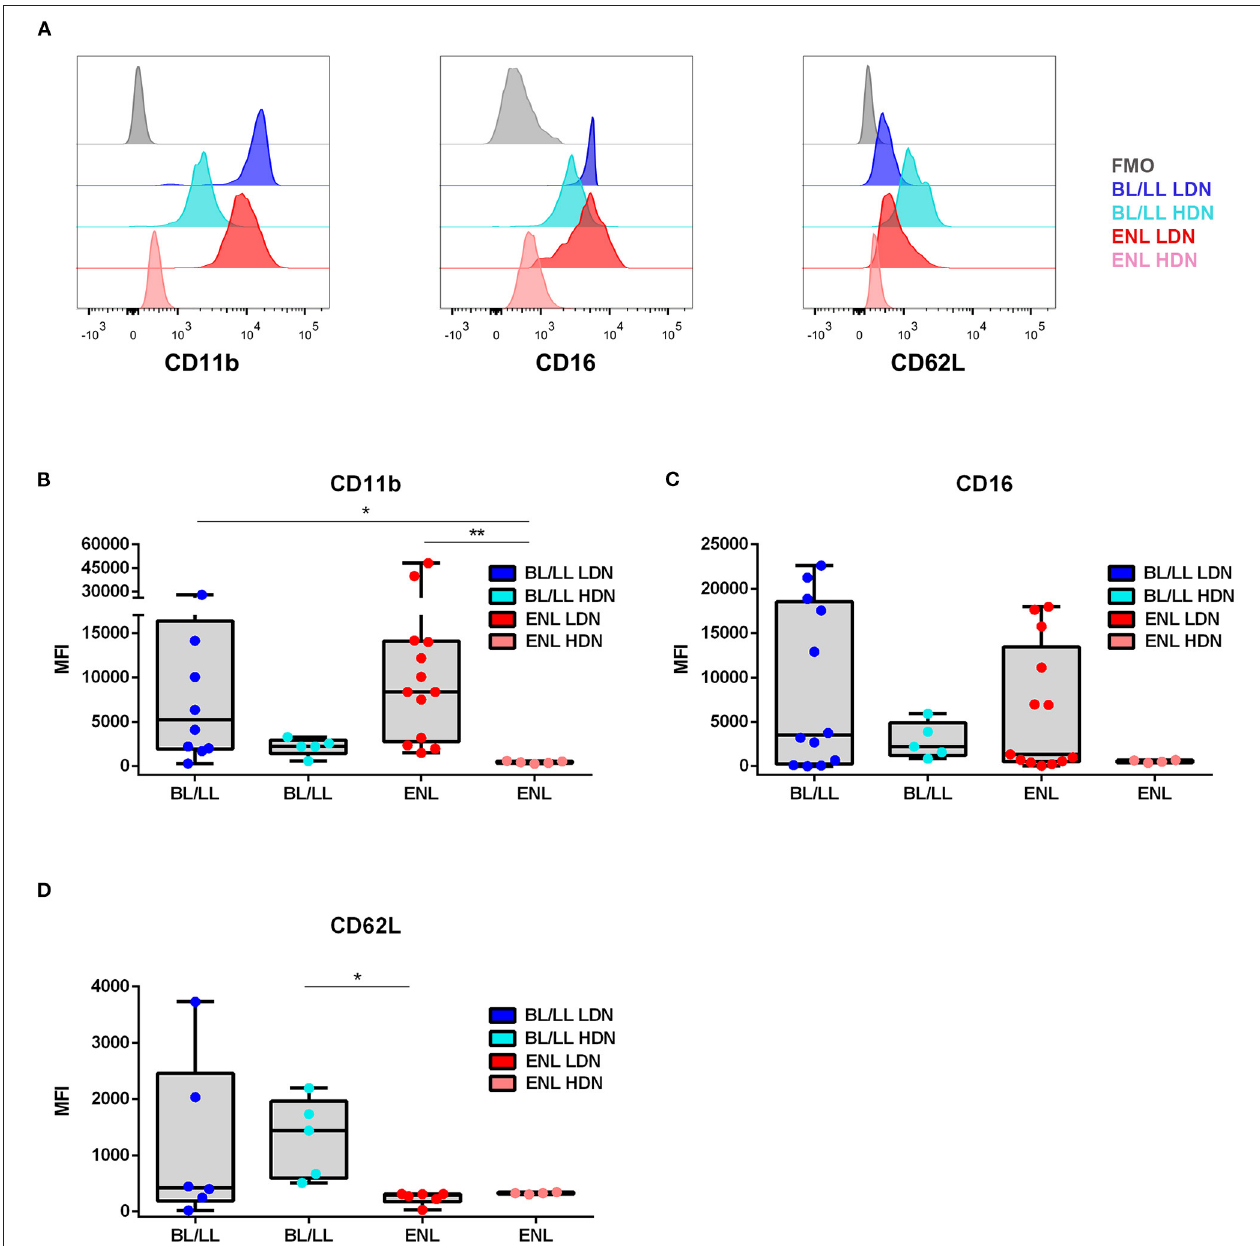
FIGURE 3 | Phenotypic profile of LDNs and HDNs of BL/LL patients with or without ENL. (A) Representative FACS analyses of CD11b, CD16, and CD62L surface expressions of leprosy patients. The mean fluorescence intensity (MFI) was calculated by subtracting the MFI from the FMO control sample of each marker in LDNs and HDNs cells. (B) CD11b expression in BL/LL (LDN n = 10; HDN n = 5), and ENL (LDN n = 13; HDN n = 5) patients. (C) CD16 expression in BL/LL (LDN n = 12; HDN n = 5); and ENL (LDN n = 13; HDN n = 4) patients. (D) CD62L expression in BL/LL (LDN n = 6; HDN n = 5) and ENL (LDN n = 6; HDN n = 4) patients. Borderline Lepromatous/Lepromatous leprosy (BL/LL) and erythema nodosum leprosum patients (ENL). Box plots show median, interquartile range, sample minimum, and maximum. Dots represent individual patients. Statistic: Kruskal–Wallis with Dunn’s post-test. * p < 0.05, ** p < 0.01.